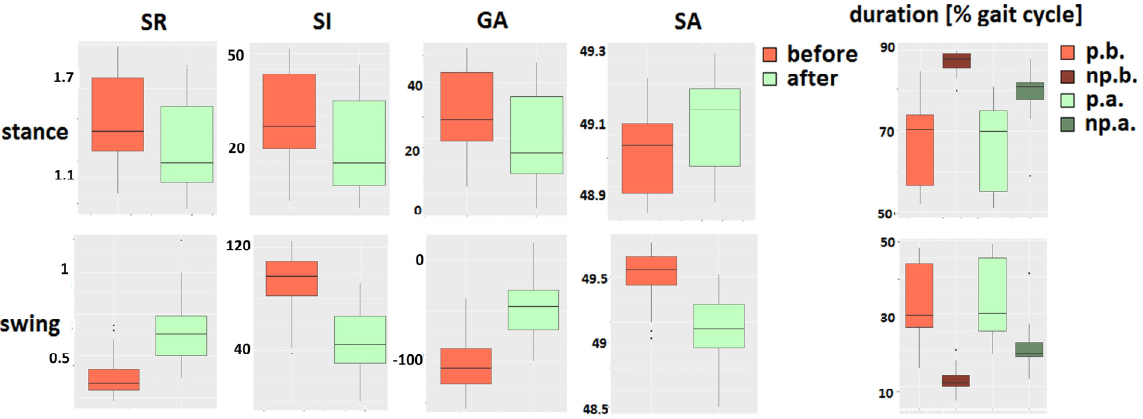
Figure 12. Boxplots of symmetry and temporal parameters for all patients’